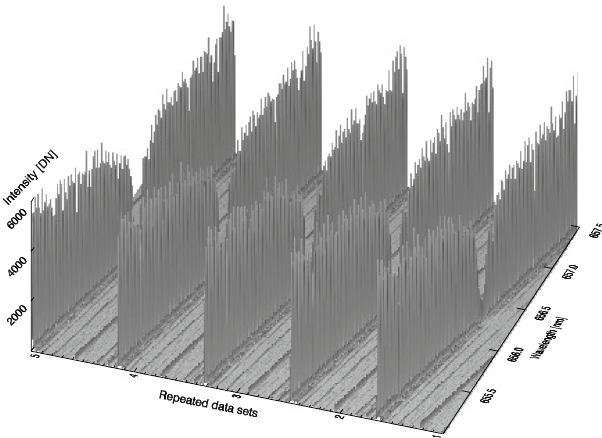
Figure 2. Bird’s-eye view of five data sets. These data sets including the spectrum were observed by Dr. Hagino and his colleagues 19 . The pixel resolution is 12.087 mÅ along the spectral dispersion direction and the LCVRs scanning step is 123.16 mÅ along the Data sets